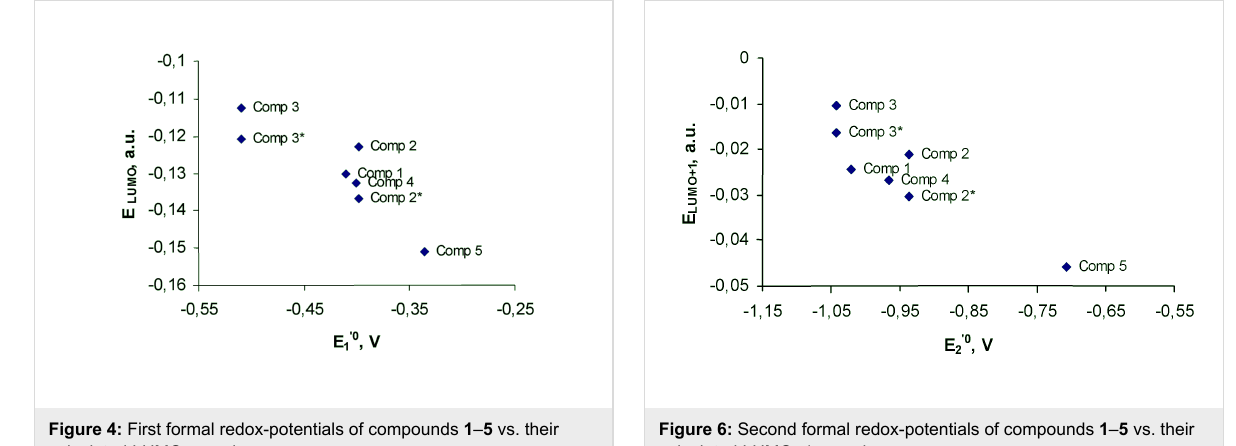
This correlation illustrates that similarly to the first redox- potentials, prediction of second redox-potentials should be performed with consideration of the conformation with the highest oxidation potential, which is conformation B for quinones 2 and 3 . The correlation on Figure 5 and Figure 6 potentials for the series of bicyclic quinones.